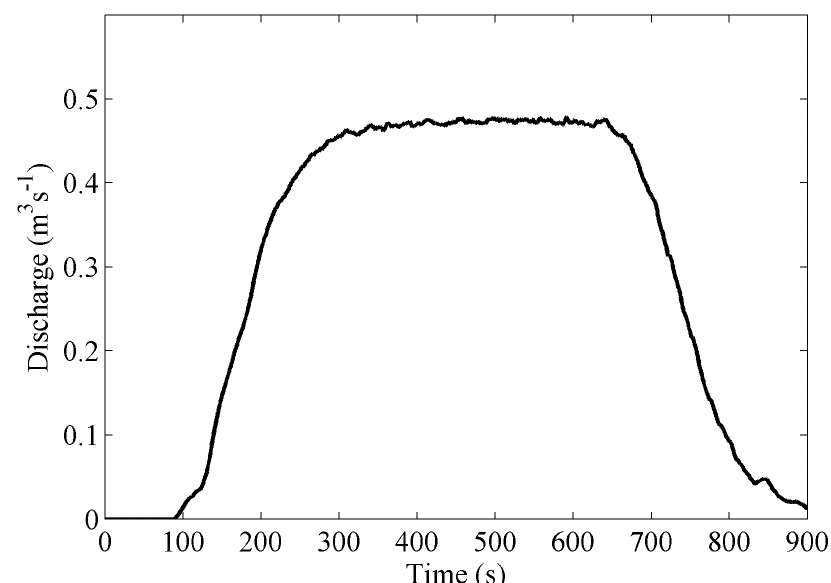
Figure 5. Water inflow at the upper boundary.